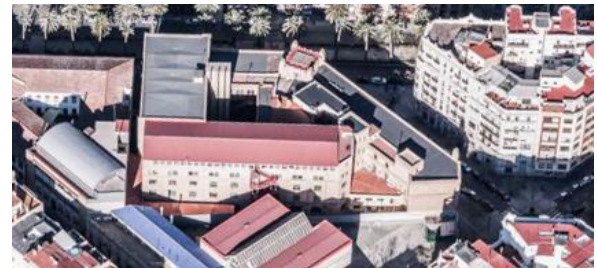
Figure 1. Aerial view of the building complex.